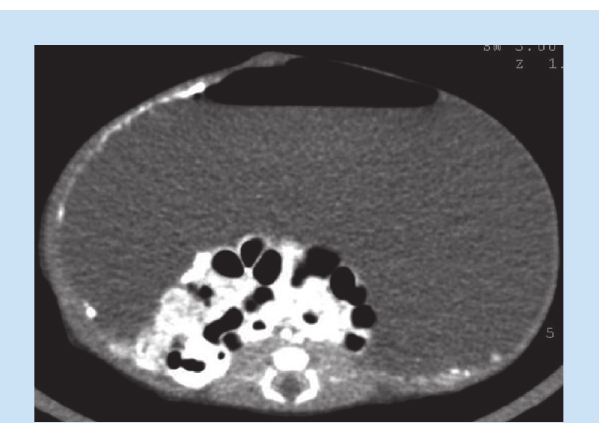
Fig. 4. Axial CT revealing anterior intraperitoneal free air. The meconium ascites causes posterior displacement of bowel loops. Note the peripheral